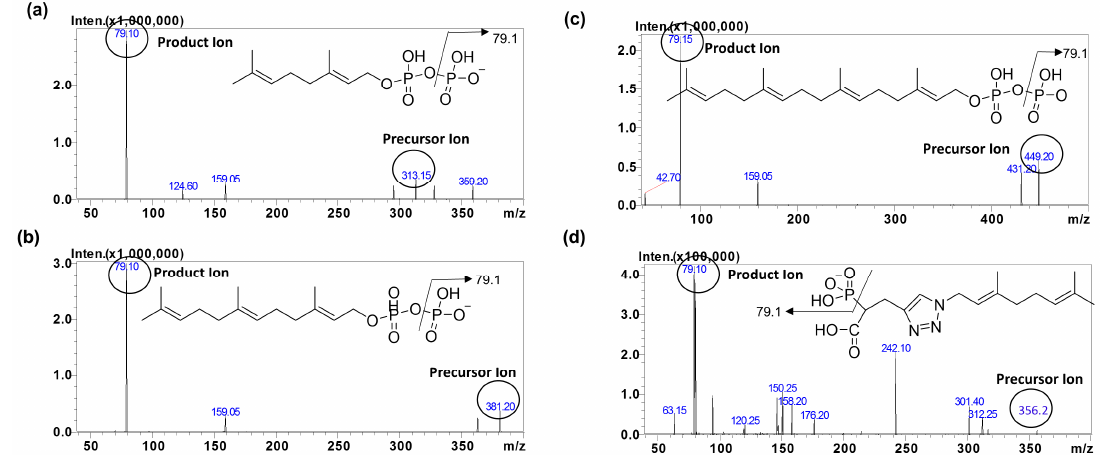
Figure 2. MS/MS product ion spectra of ( a ) GPP, ( b ) FPP, ( c ) GGPP and ( d ) RAM1147 (internal Standard).